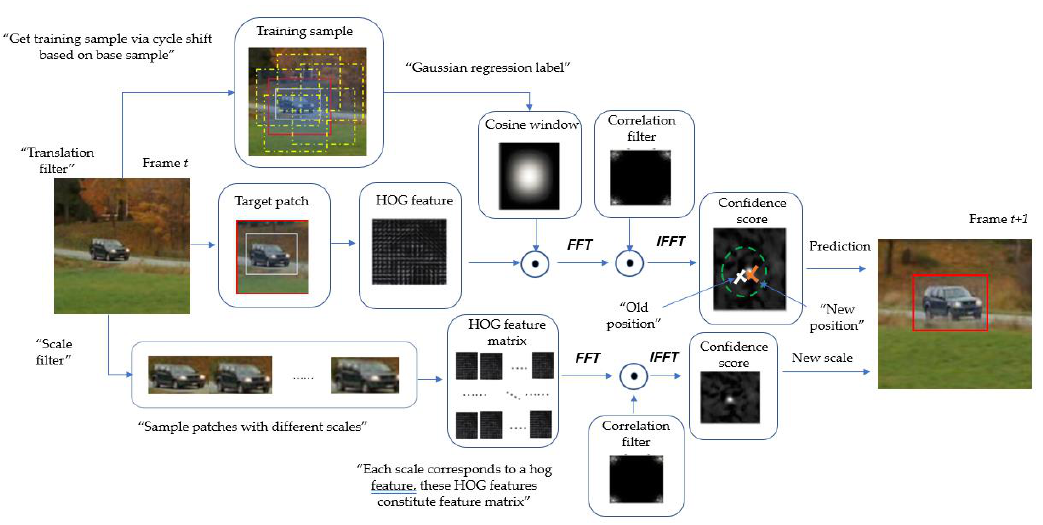
Figure 5. Training of classifier and target prediction process. For translation filter, training sample was generated via cycle shift (yellow dotted box) based on base sample and training the filter with target histogram of oriented gradients (HOG) or gray feature. For scale filter, samples of different scales are constructed based on the target position, and these samples will be used as the training samples of the scale filter. “ FFT ” and “ IFFT ” denote fast Fourier transform and inverse fast Fourier transform, respectively.